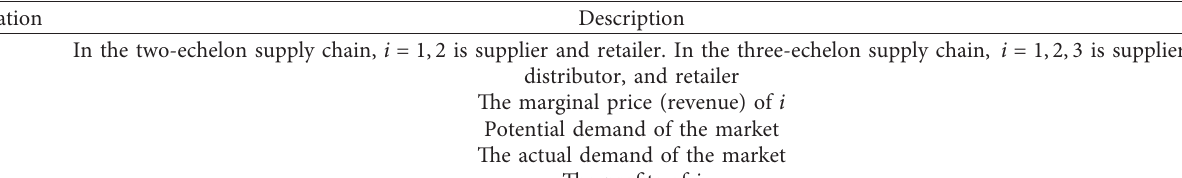
Table 1: Notation and